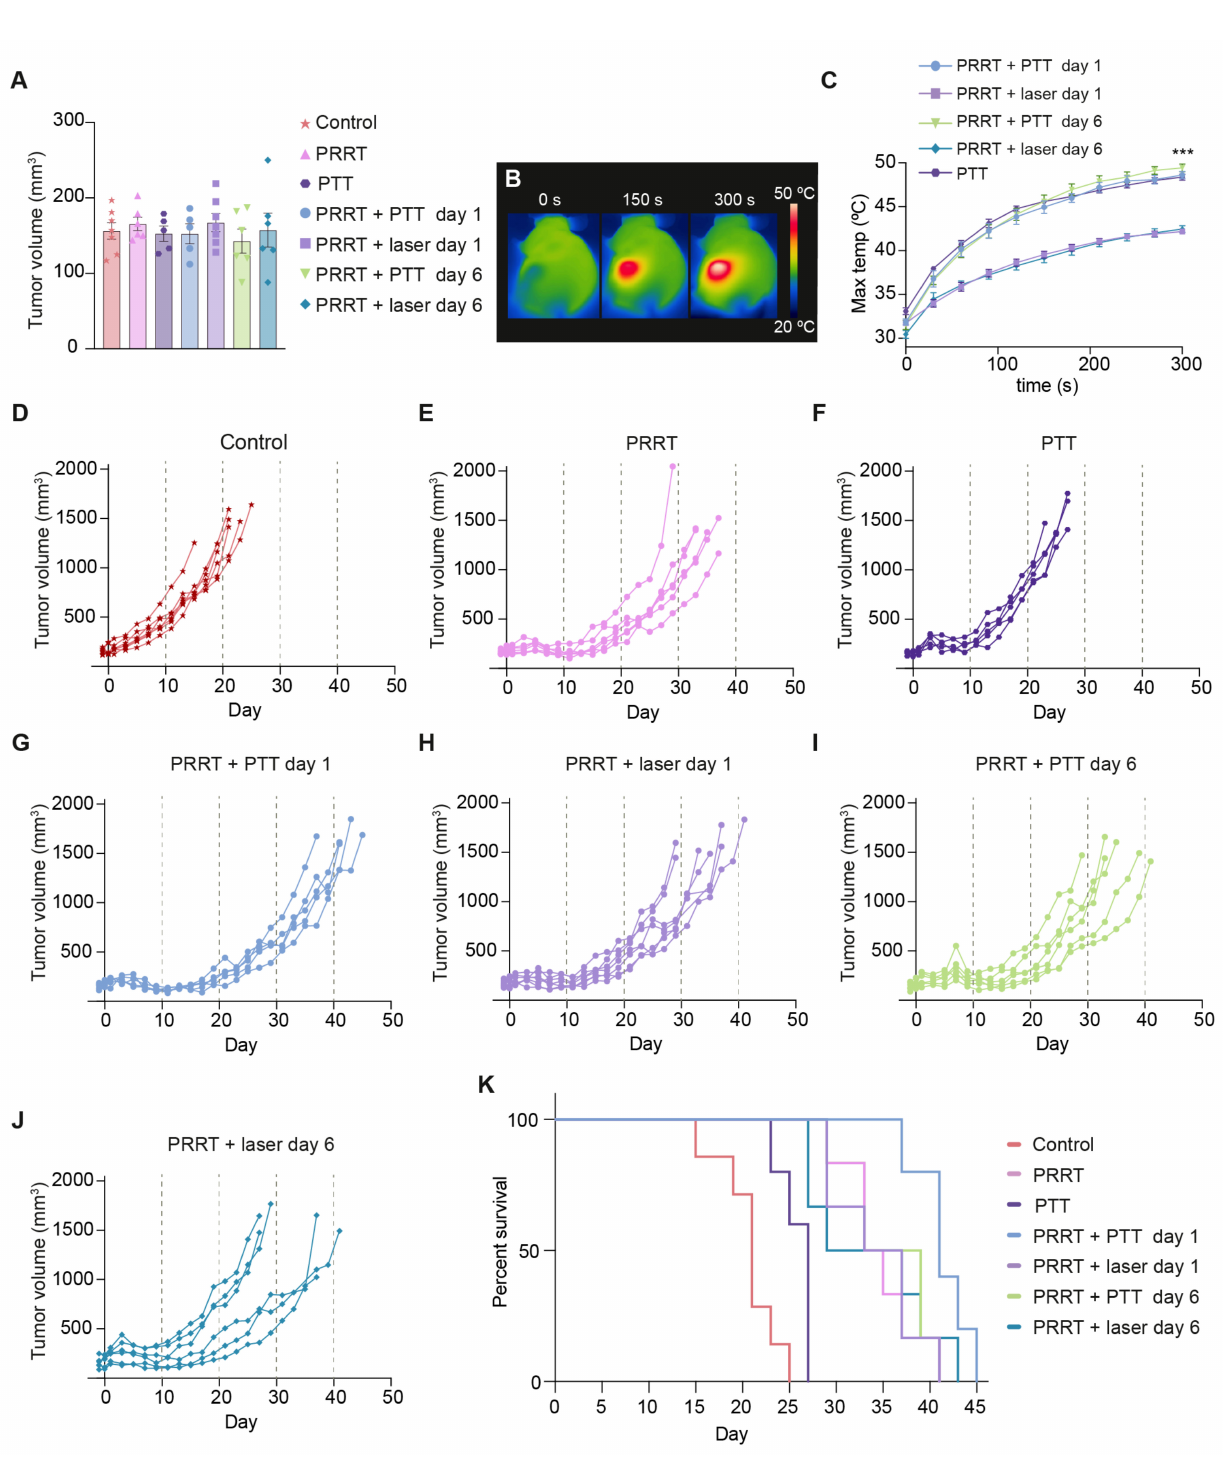
Figure 3. Evaluation of the treatment effect of [ 177 Lu]Lu-DOTA-TATE PRRT and NS-based PTT in NCI-H69 tumor-bearing mice. ( A ) Tumor volume at day − 1 for all groups. Data shown as mean ± SEM. ( B ) Representative thermal images of a mouse undergoing NS-based PTT. ( C ) Maximum surface temper- atures on the tumors recorded with a thermal camera during the five-minute irradiation. Data shown as mean ± SEM. Temperatures at t = 300 s for all PTT mice vs. all laser mice were compared. *** represents p < 0.001. ( D – J ) Tumor growth curves for all mice in each of the groups. Animals were euthanized when tumors reached humane endpoints. (Control group; n = 7, PRRT group; n = 6, PTT group; n = 5, PRRT + PTT day 1 group; n = 5, PRRT + laser day 1 group; n = 7, PRRT + PTT day 6 group; n = 6, and PRRT + laser day 6 group; n = 6). ( K ) Survival curves for all